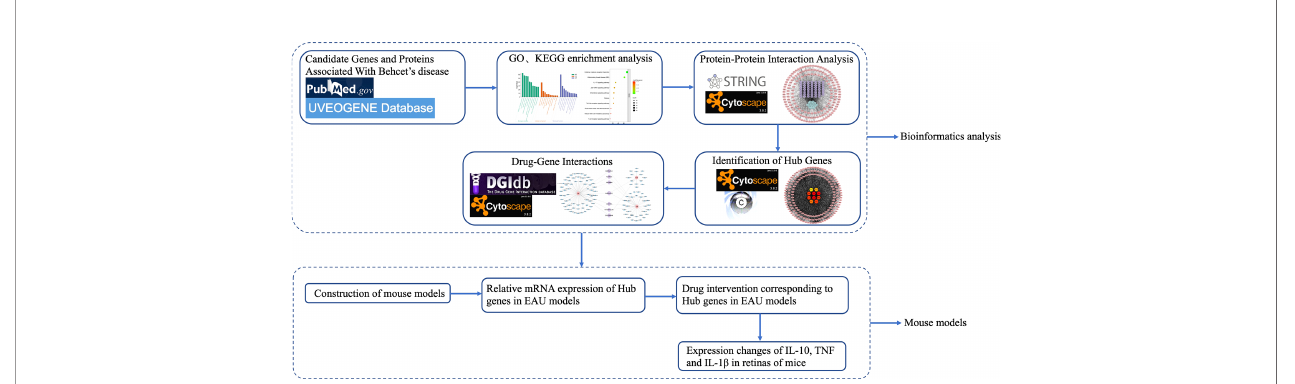
FIGURE 1 | The fl owchart of this study.